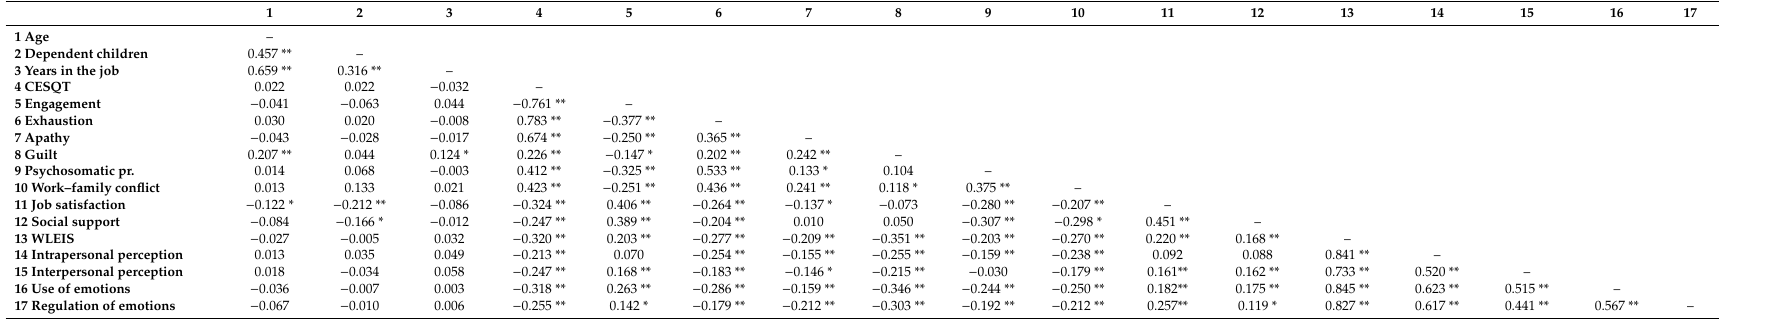
Table 2. Correlation